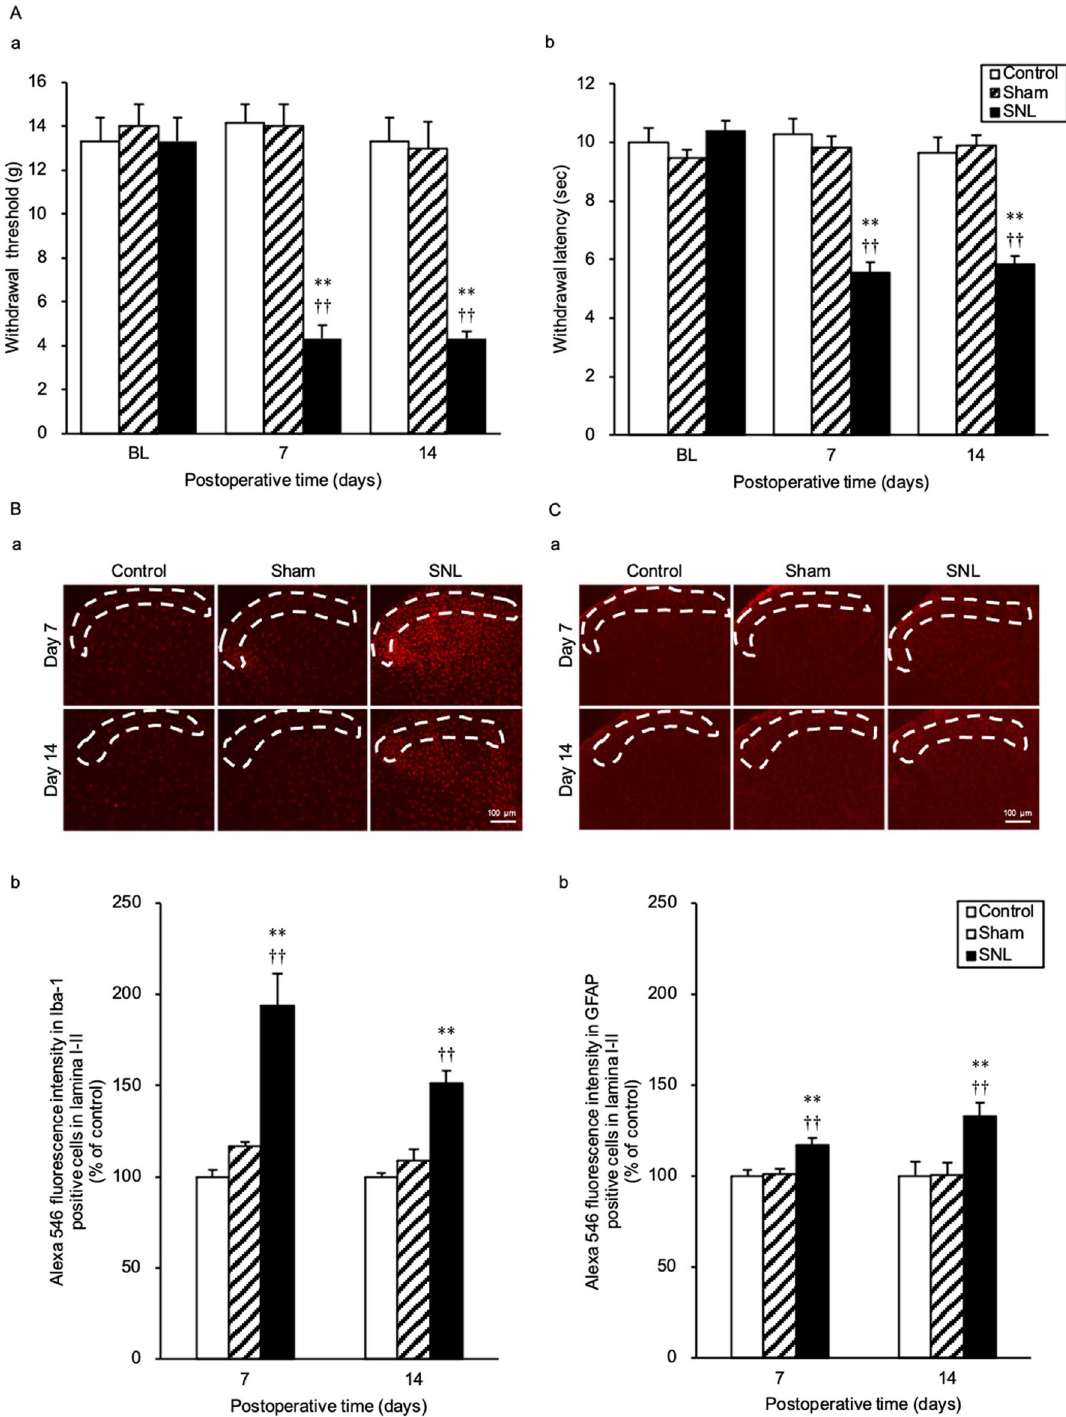
Figure 1. SNL induces mechanical and thermal hyperalgesia and increases the number of Iba-1 and GFAP-positive cells in the L5 ipsilateral dorsal horn at day 7 and 14 after SNL in AVP-eGFP Tg rats. ( A ) The change of mechanical and thermal nociceptive threshold. ( a ) Mean values of withdrawal thresholds to von Frey hair stimulation of the ipsilateral hind paw at the baseline (BL) on days 7 and 14 after SNL operation in Control, Sham surgery, and SNL rats. ( b ) Mean value of withdrawal latency to thermal stimulation of the ipsilateral hind paw at the BL and days 7 and 14 after SNL operation. ( B ) Change in ionised calcium-binding adapter molecule 1(Iba-1)-positive cells in the lumbar segment 5 (L5) ipsilateral dorsal horn. ( a , b ) Digital image of Iba-1-positive cells in the L5 ipsilateral dorsal horn and the average Alexa 546 fluorescence intensity in Iba-1 positive cells in laminae I–II. ( C ) Change in glial fibrillary acidic protein (GFAP)-positive cells. ( a , b ) Digital image of GFAP-positive cells in the L5 ipsilateral dorsal horn and the average Alexa 546 fluorescence intensity in GFAP-positive cells in laminae I–II. Sections were obtained from Control, Sham, and SNL groups on days 7 and 14 after SNL surgery. The area surrounded by a white dotted line indicates the layer of laminae I–II. Data are presented as the mean ± SEM (one-way ANOVA). n = 5–6 per group. ** p < 0.01 compared with each Control experiment. †† p < 0.01 compared to Sham